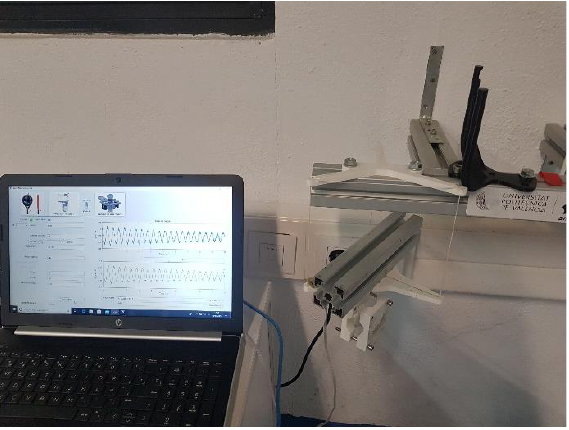
Figure 14. One of the references used to calibrate horizontal MOI test stand.